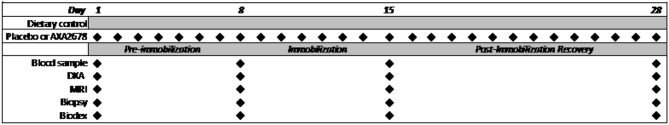
Schematic of study protocol showing the periods of the study and timing of data collection.